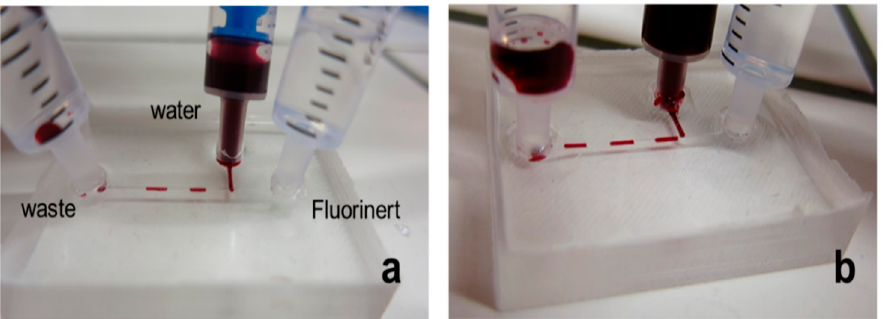
Figure 3. Example of the production of droplets using a monolithic PDMS-based device: ( a ) scheme of the setup; ( b ) formation of droplets.